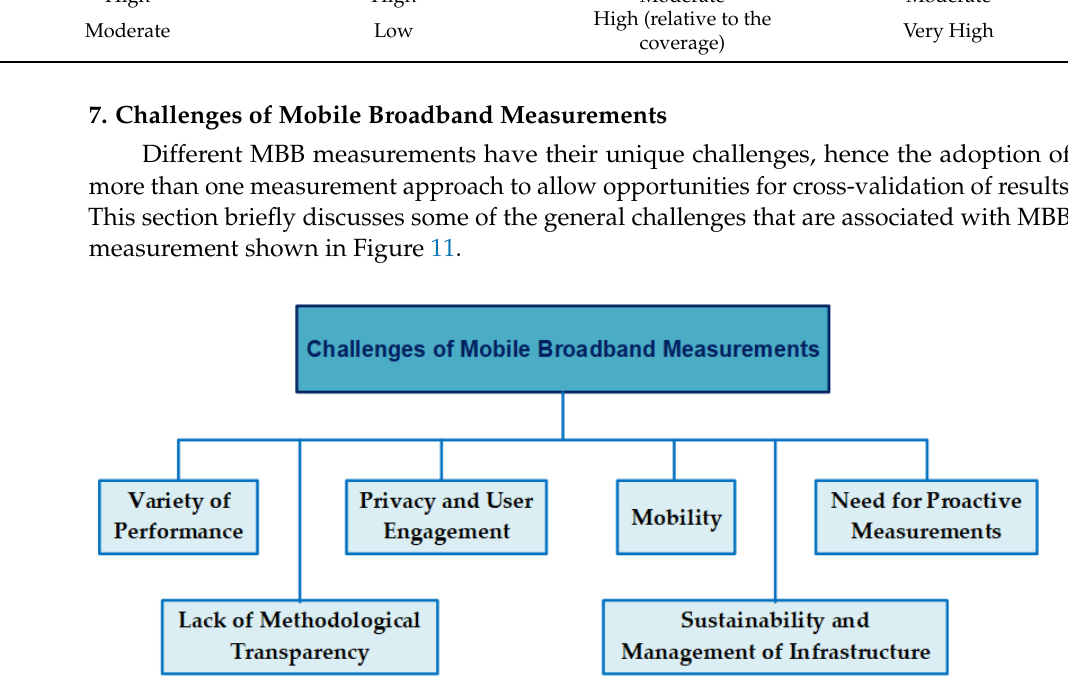
Figure 11. MBB measurements challenges.